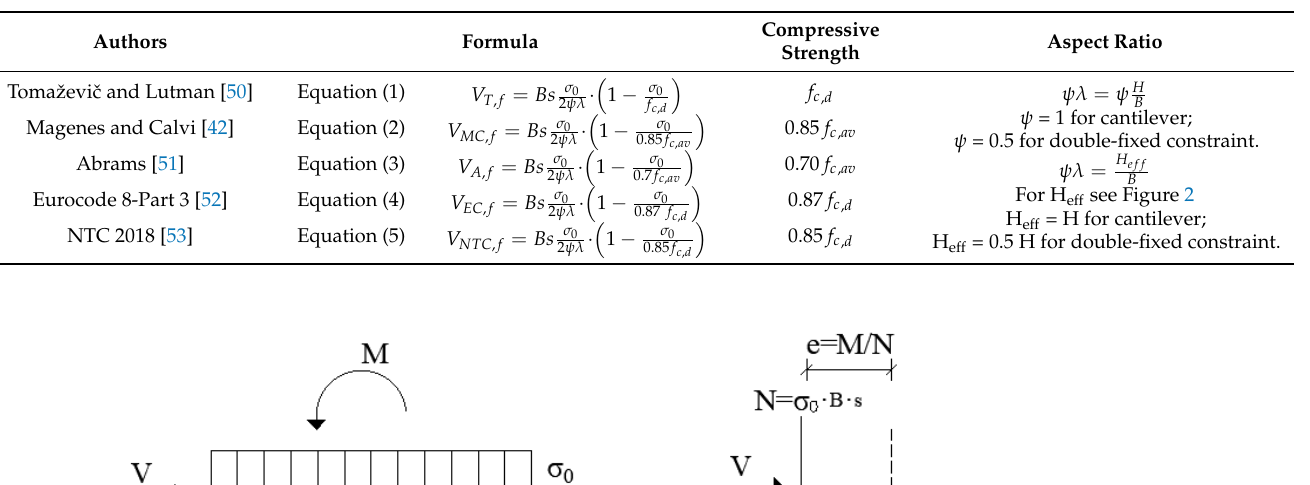
Table 1. Literature formulations used to predict the flexural capacity.